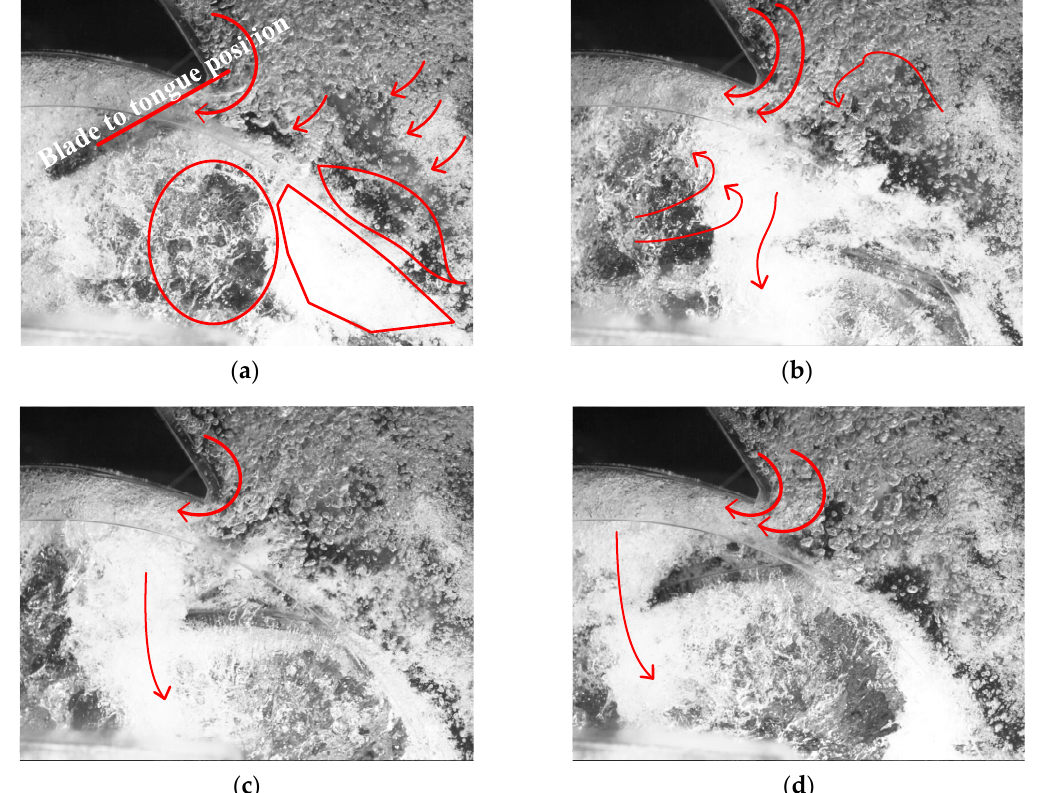
Figure 12. Instantaneous flow pattern for φ = 0.06 at α i = 4.2% at different time: ( a ) t 0 ; ( b ) t 0 + T /4; ( c ) t 0 + T /2; and ( d ) t 0 + 5 T /6.